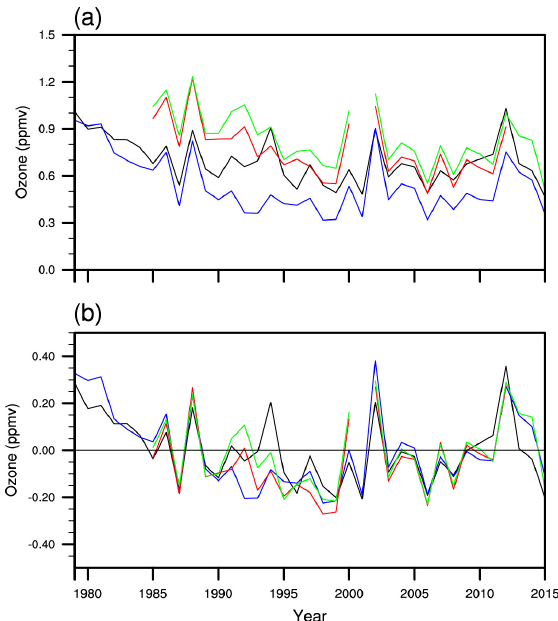
Figure 1. (a) Time series of original ozone concentrations in the southern high-latitude lower stratosphere in austral spring averaged over the region 60–90 ◦ S at 200–50hPa for the MERRA2 (black line) and SLIMCAT (blue line) ozone datasets and over the re- gion 60–75 ◦ S at 200–50hPa for the GOZCARDS (red line) and SWOOSH (green line) ozone datasets. (b) Same as (a) , but the ozone variations are removed the seasonal cycles and linear